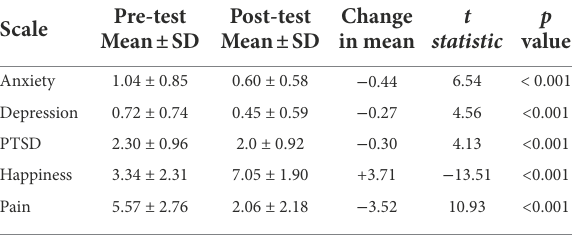
TABLE 2 Measures outcomes pre- and post-EcoMeditation training ( N =